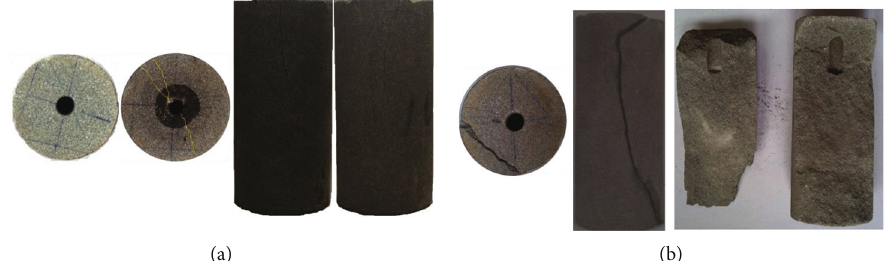
Figure 8: Fracture morphology of sandstone hydrofracture. (a) Hydrofracture with uniaxial compression. (b) Diagram of triaxial compression